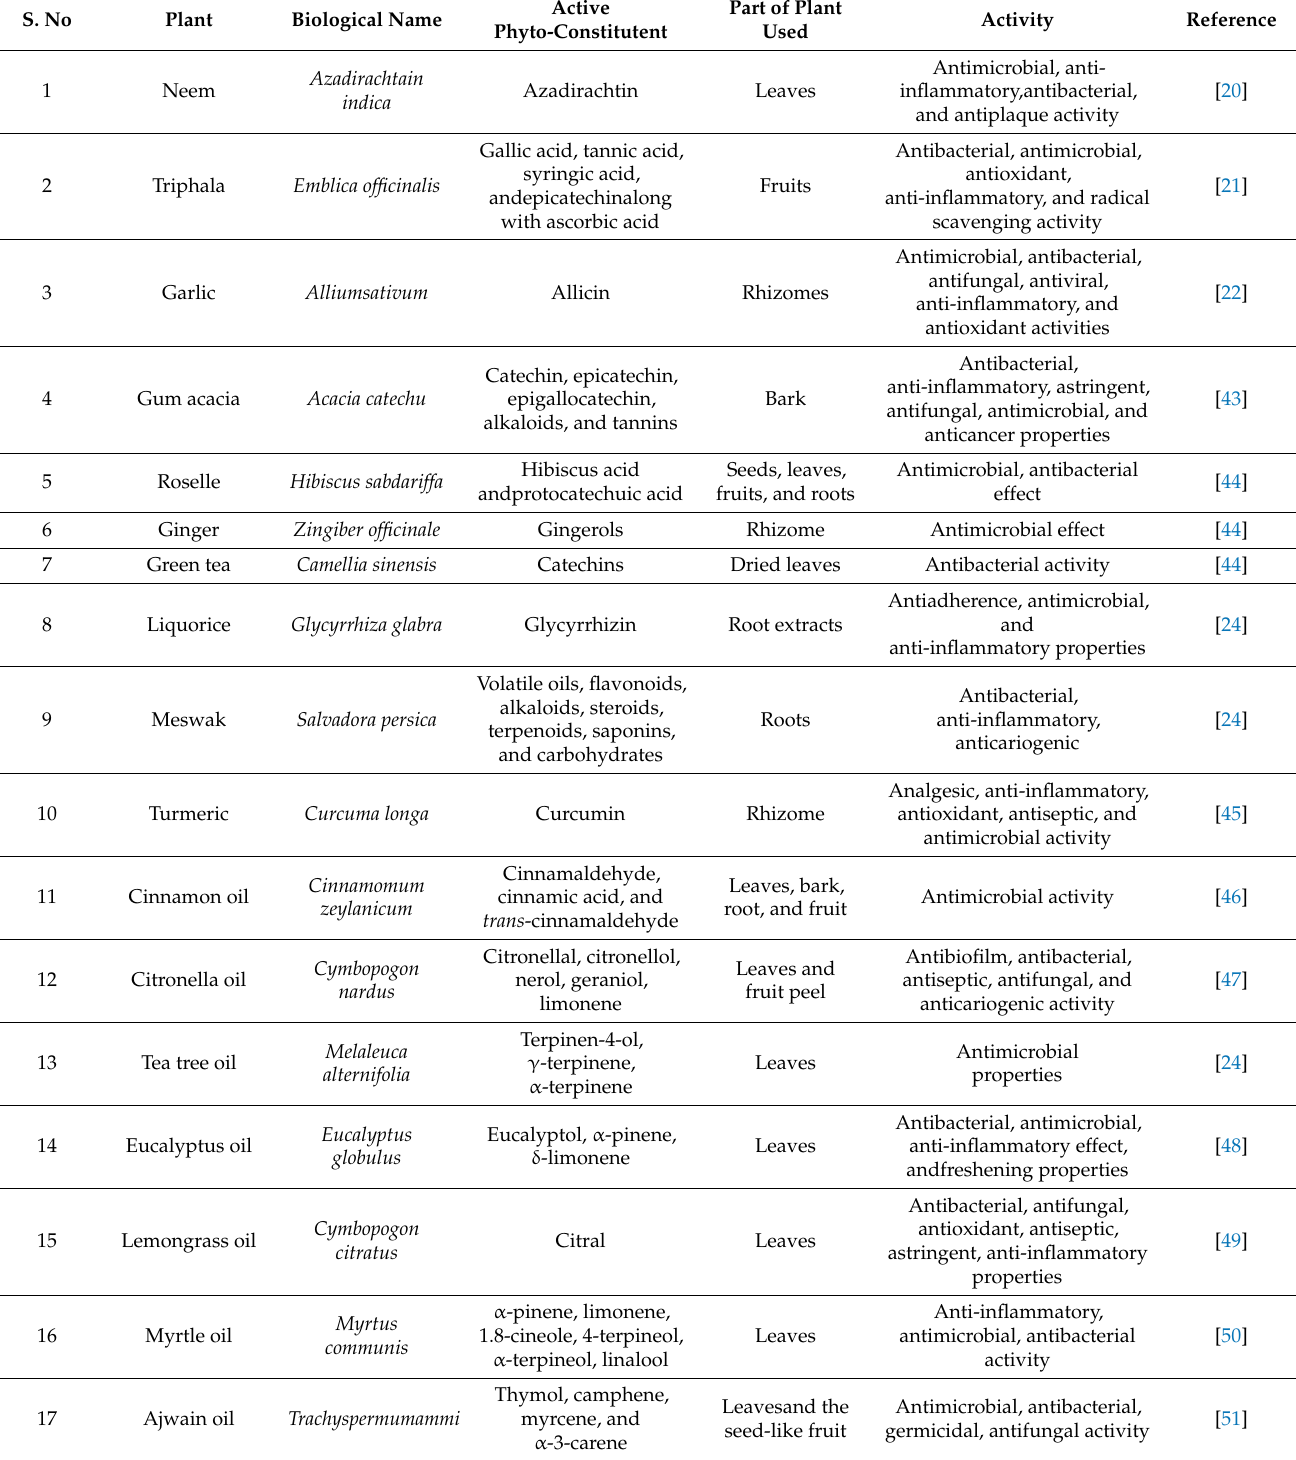
Table 1. List of different phytoconstituents obtained from herbal sources along with their potential pharmacological activity in oro-dental